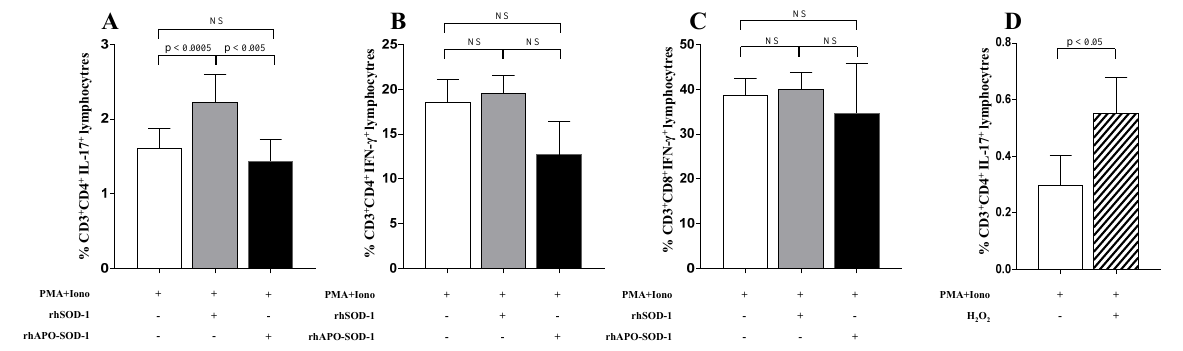
Figure 9. Addition of enzymatic active recombinant SOD-1 and H 2 O 2 to activated T cells, significantly increased in vitro IL-17 production by CD4 + T lymphocytes. To evaluate the cytokine production, in vitro, an overnight culture of PBMC in the presence of PMA and ionomycin was performed. White columns indicate cultures with PMA and ionomycin alone; grey columns indicate cultures with recombinant human SOD-1 (rhSOD-1); black columns represent cultures with metal-depleted SOD-1 molecules (rhApo -SOD-1). ( A ) IL-17 production by CD4 + T lymphocytes. ( B ) IFN- γ production by CD4 + T lymphocytes. ( C ) IFN- γ production by CD8 + T lymphocytes. ( D ) IL-17 production by CD4 + T lymphocytes in the presence of PMA and ionomycin alone (white column) or after addition of H 2 O 2 (50 mM) in the last 4 h of culture (striped column). Statistical evaluation of data was performed by means of the Wilcoxon matched-paired